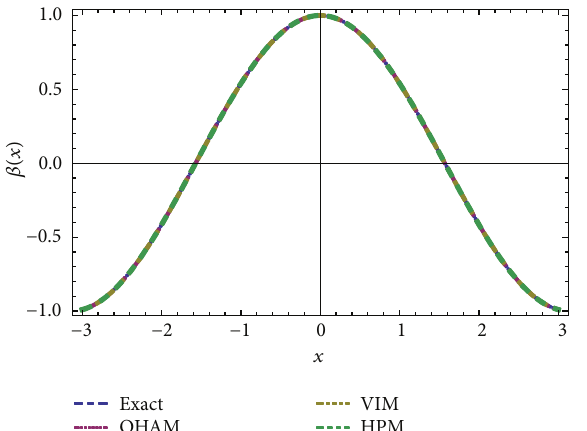
Figure 22: 2D, comparison of OHAM, VIM, HPM, and exact solutions for 𝛽(𝑥,𝑡) at 𝑡 = 0.1 .